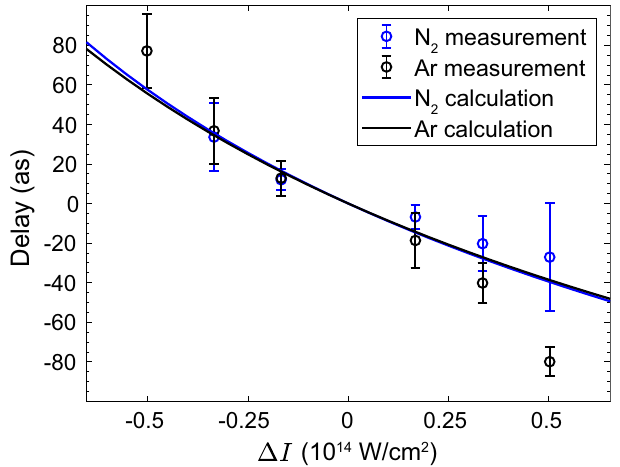
Figure 4. Coulomb time delays. Measured (circles) and calculated (lines) Coulomb induced delays as a function of intensity variation, extracted for electrons with a final kinetic energy of approximately 3 eV, in argon (black) and nitrogen